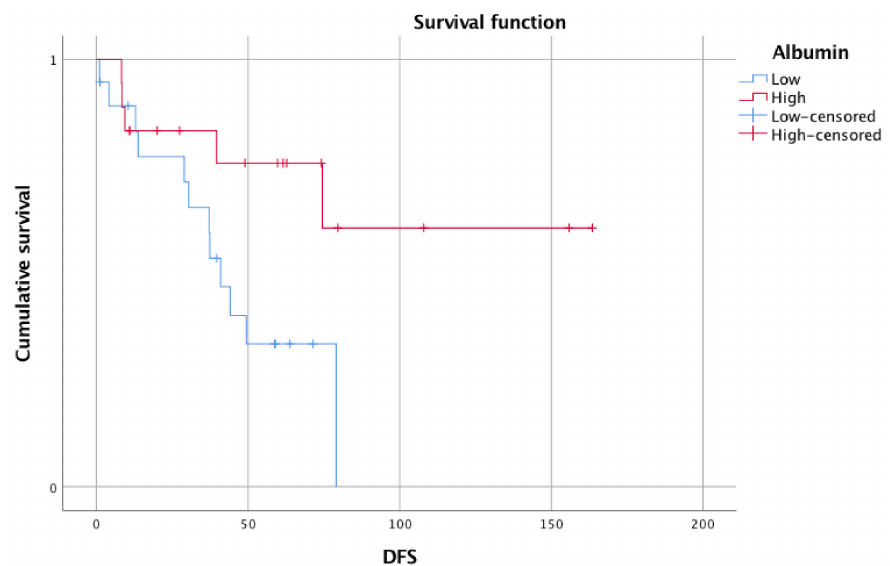
Figure 2. Kaplan–Meier survival curve for DFS for patients stratified according to median prethera- peutic serum albumin value. The DFS for the low albumin group ( n = 19) was shorter than for the high albumin group ( n = 18). A log-rank test revealed a statistically significant difference ( p = 0.029). DFS: disease-free